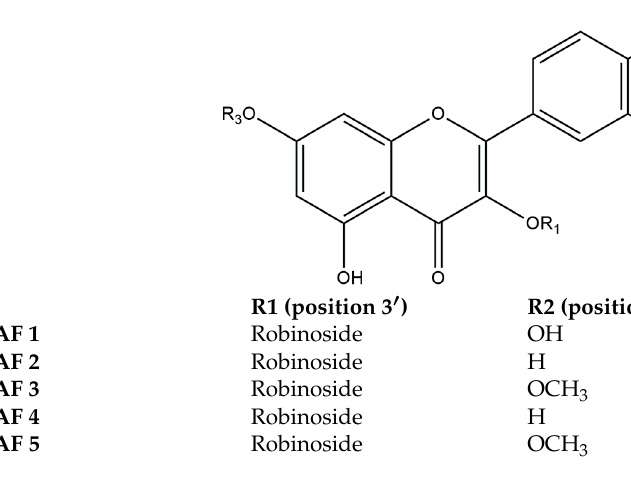
Figure 2. Chemical structures of flavonoids GAF 1 – 5 isolated from the leaves of Genipa americana .